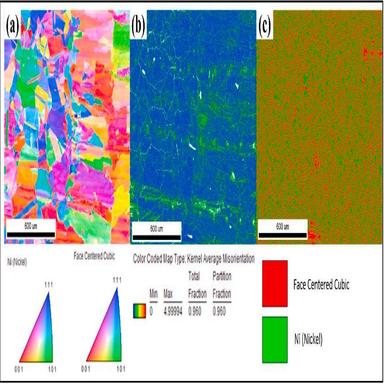
EBSD scan at IN 800HT weld interface: (a) IPF map, (b) KAM map, (c) phase map.